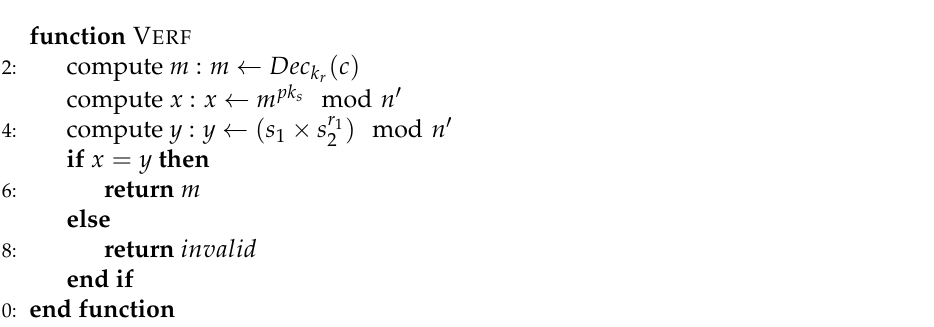
Algorithm 2 Verification